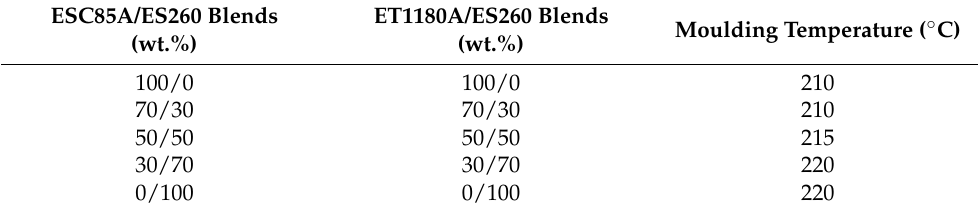
Table 2. Compositions of TPU blends and moulding